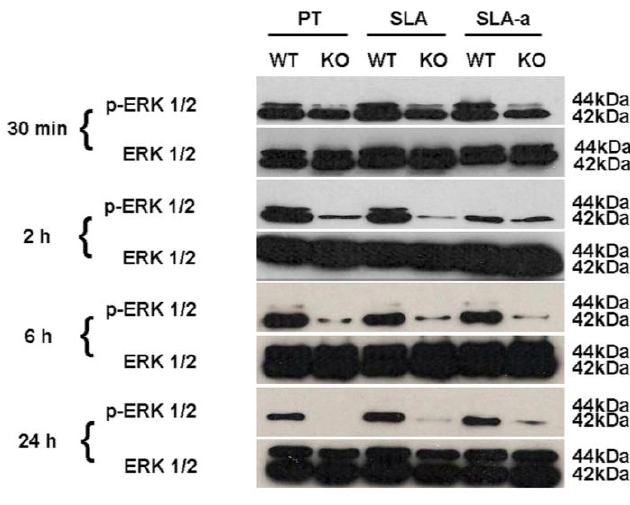
6. Influence of substratum topography and hydrophilicity on ERK 1/2 phosphorylation in FAK −/− and WT fibroblasts. Western blotting using specific antibodies to phosphorylated and total ERK 1/2 at 30 mins, 2, 6 and 24 h post seeding. ERK 1 is 44 kDa (upper band) and ERK 2 is 42 kDa (lower